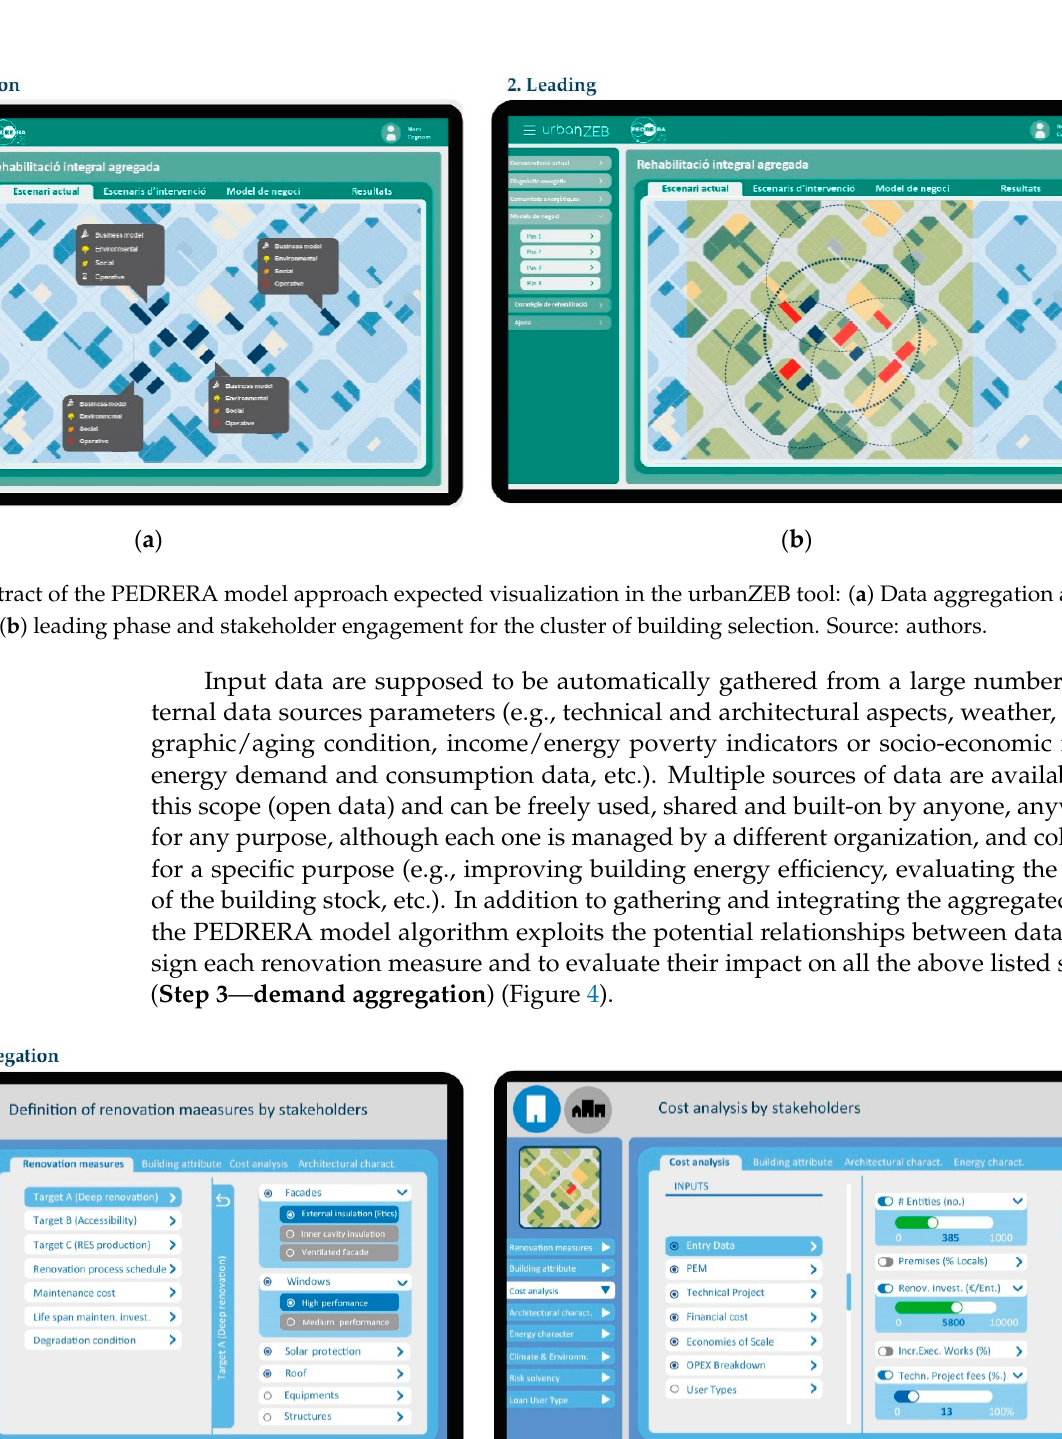
( b ) Figure 5. Extract of the PEDRERA model approach, expected visualization in the urbanZEB tool: ( a ) concept design based on financial appraisal and KPIs prioritization; ( b ) scenario visualization for scenario selection according to priorities from stakeholders. Source: authors. PEDRERA Model Input Table 1 provides a summary of the inputs required by the PEDRERA model to properly run simulations. Most of the input data for the algorithms are already collected from public sources and from case study sources and integrated in the urbanZEB tool (e.g., cadaster, energy performance certificates and census, among other) by Semantic Web processing. Each input is systemized in the model framework in order to predicts the suitable output (KPIs) for given inputs. The input’s features are namely: type of issue and type of parameter , indicator , unit , scope (the goal where input is adopted), data source (imported from database, calculated, simulated), scale (building, district, urban area/census unit) and source dataset .